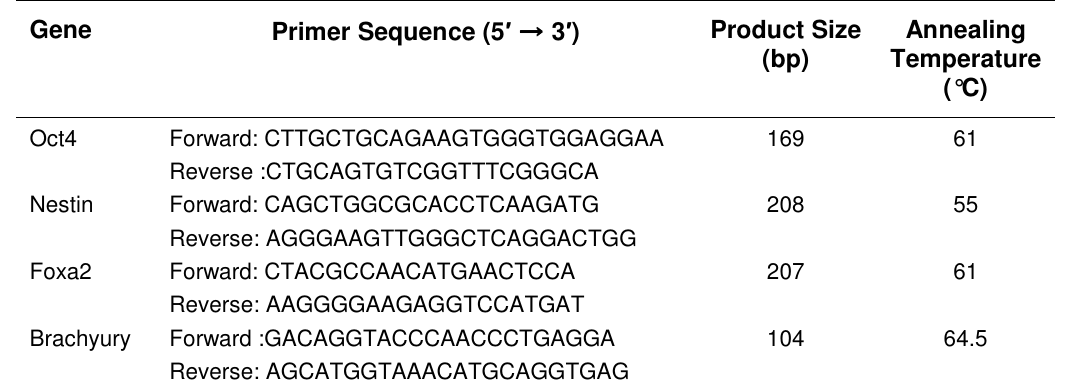
Primer Sequence Information for